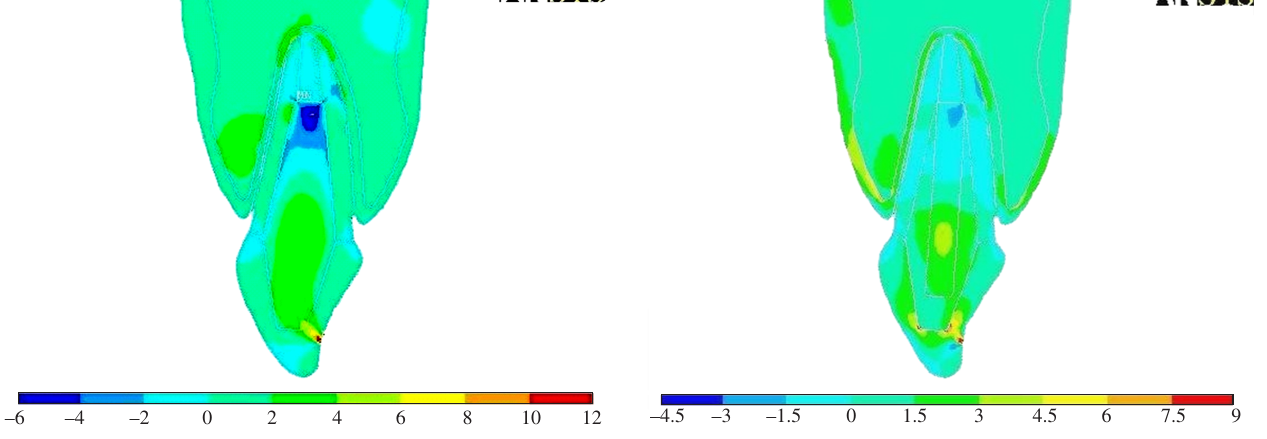
Figure 3. Shear stress (MPa) distribution in Model 1.